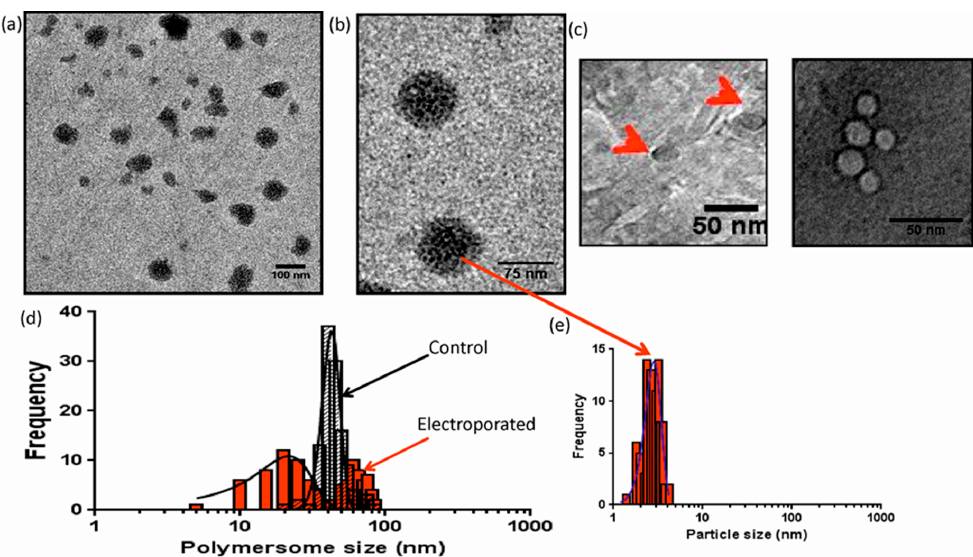
Figure 2. ( a ) The formation of iron oxide nanoparticles within tri-block PMOXA–PDMS–PMOXA polymersomes as the result of electroporation; ( b ) an example of a magnetopolymersome (at higher magnification) showing the distribution of nanoparticles within the polymersomes; ( c ) cryogenic TEM of magnetopolymersomes (indicated by red arrows in image) with electron density in both the polymersome core and within the membrane and of a size (37 ± 9 nm) in agreement with the DLS; ( d ) the change in polymersome size before and after electroporation with unelectroporated control polymersomes (striped bars) with an average size of 45 ± 8 nm. After electroporation, a dual polymersome population at 20 and 60 nm is observed, giving an average polymersome size of 43.0 ± 2.4 nm; and ( e ) the corresponding MNP grainsizing from TEM, showing the average electroporated nanoparticle to be 2.6 ± 0.9 nm in diameter. The magnetopolymersome were shown to be superparamagnetic by VSM analysis (Figure S4).